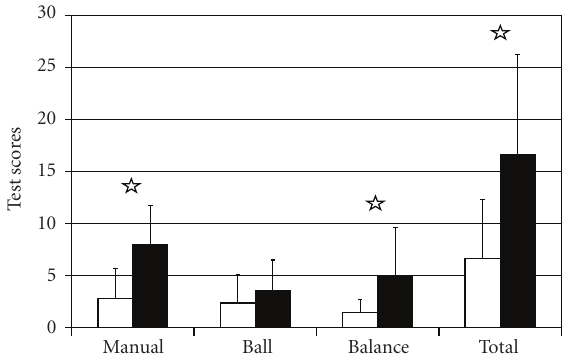
Figure 4: Plot of Movement ABC scores by test subset in children with 1 or no VEMP present. White columns = HI children who lost hearing later ( N = 9); Dark columns = HI children who lost hearing neonatally ( N = 24). (Star = P <